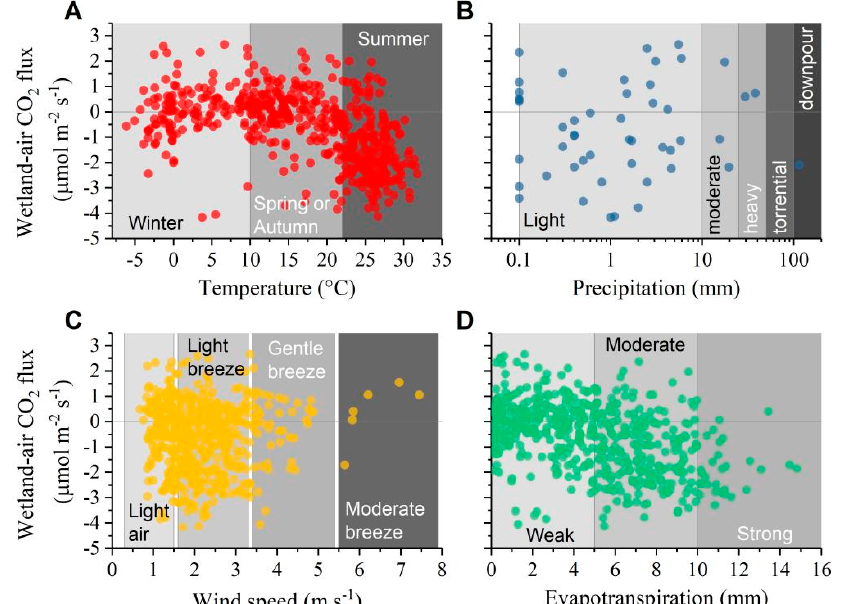
Figure 6. Relations between the daily wetland-air CO 2 fluxes and the four meteorological variables of ( A ) temperature, ( B ) precipitation, ( C ) wind speed, and ( D ) evapotranspiration; As the gray band darkens, the level of the corresponding meteorological factors increases. Note: the intervals of the meteorological variables comply with the related national standards in China.